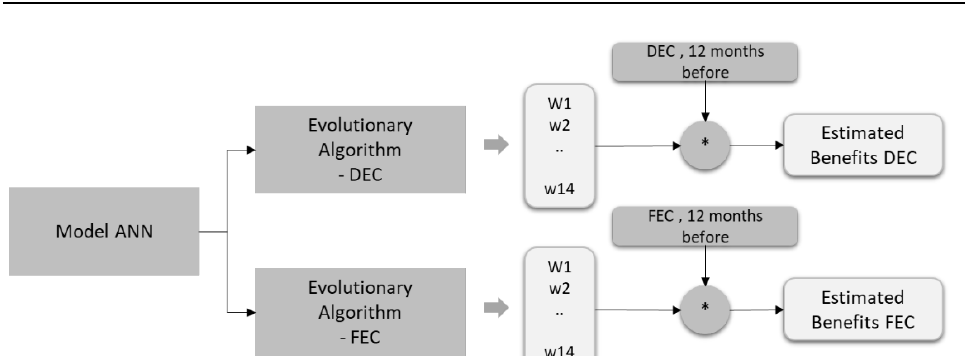
Figure 6. Structure of the simulations and expected results.